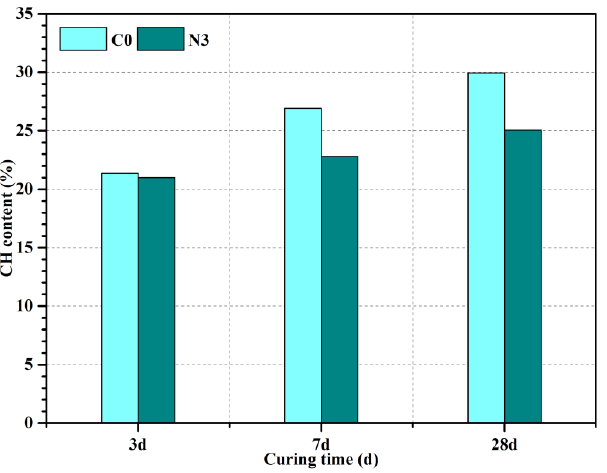
Figure 17. CH content of different cement pastes.